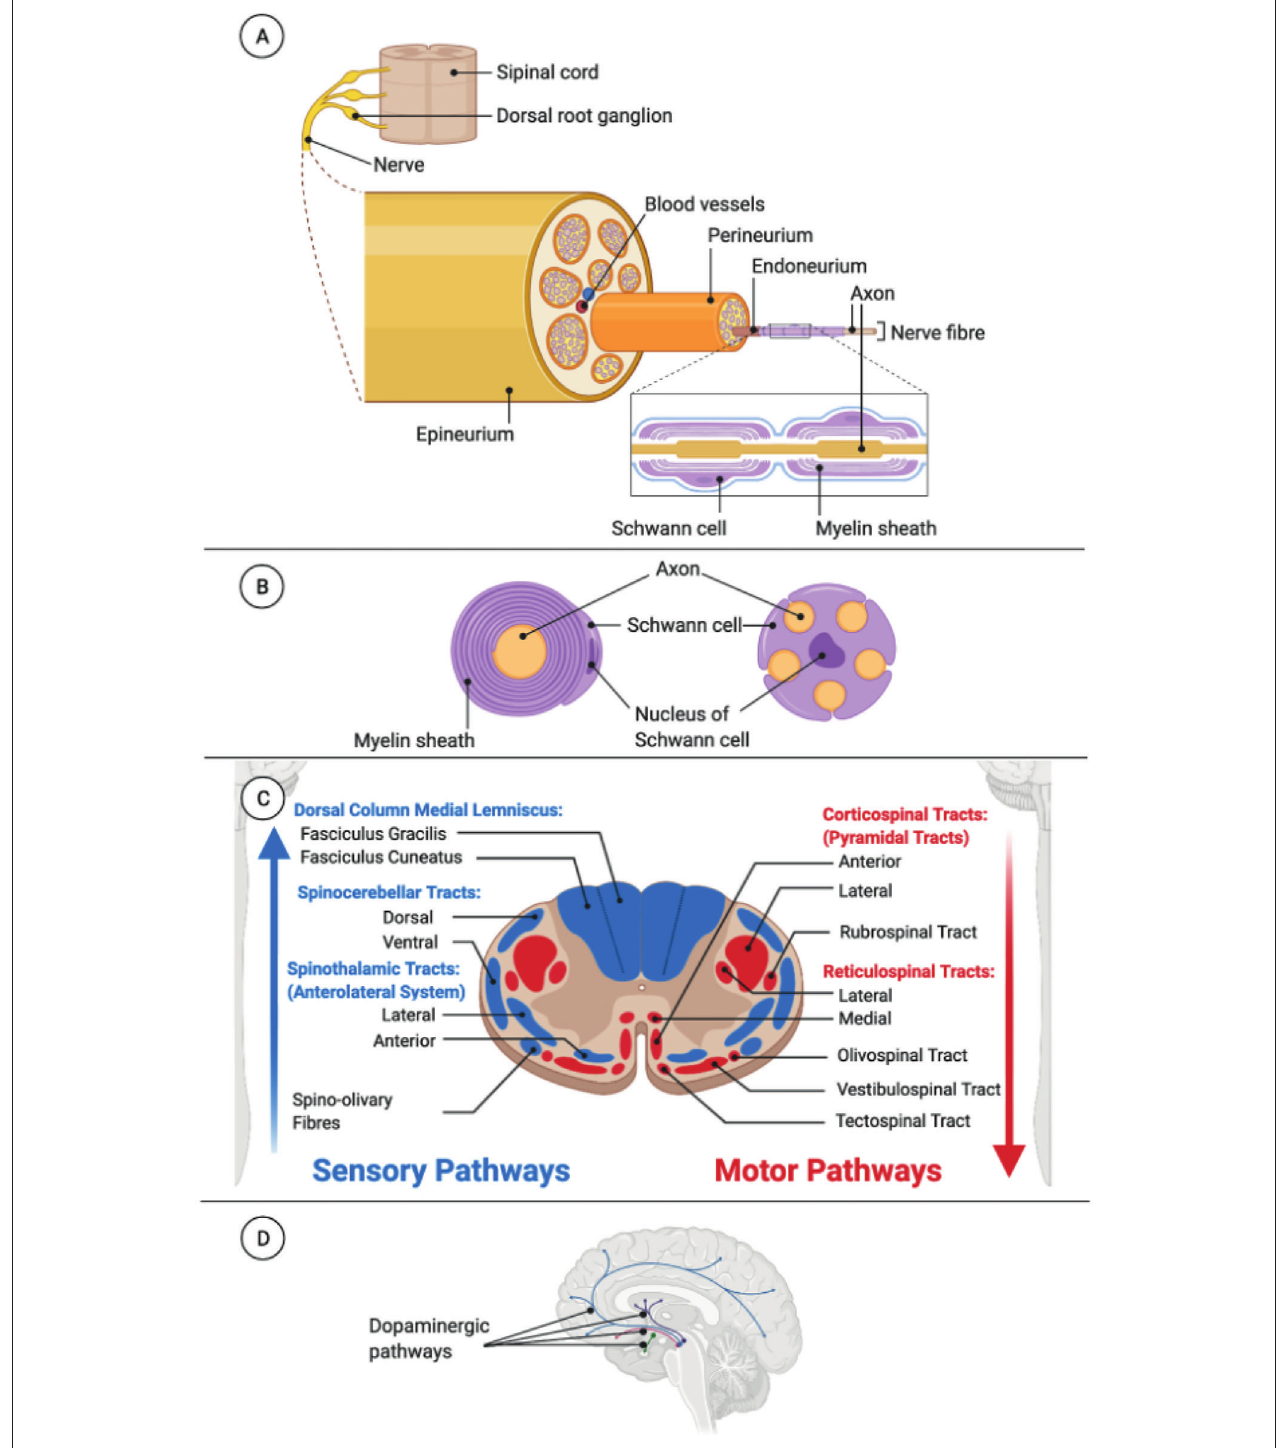
FIGURE 3 | Bundles of axons in the nervous system. (A) Peripheral nerve anatomy. (B) Myelinated (left) and unmyelinated (right) nerve fibers in the peripheral nervous system. (C) Spinal cord tracts divided in sensory or ascending tracts (blue) and motor or descending tract (red) to illustrate the complexity of the tract organization in the spinal cord. (D) Dopaminergic pathways as an example of the large number of pathways inside the brain. Dopaminergic pathways are the bundles of neuron projections in the brain that synthesize and release the neurotransmitter dopamine. Alterations in these pathways may be involved in multiple diseases and disorders such as Parkinson’s disease, addiction, or attention deficit hyperactivity